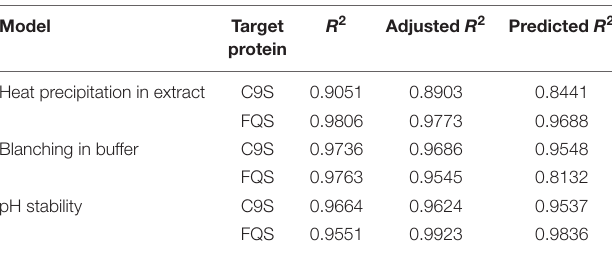
TABLE 1 | Quality parameters of the predictive models for heat precipitation in extract, blanching in buffer and the pH stability of C9S and FQS derived from DoE